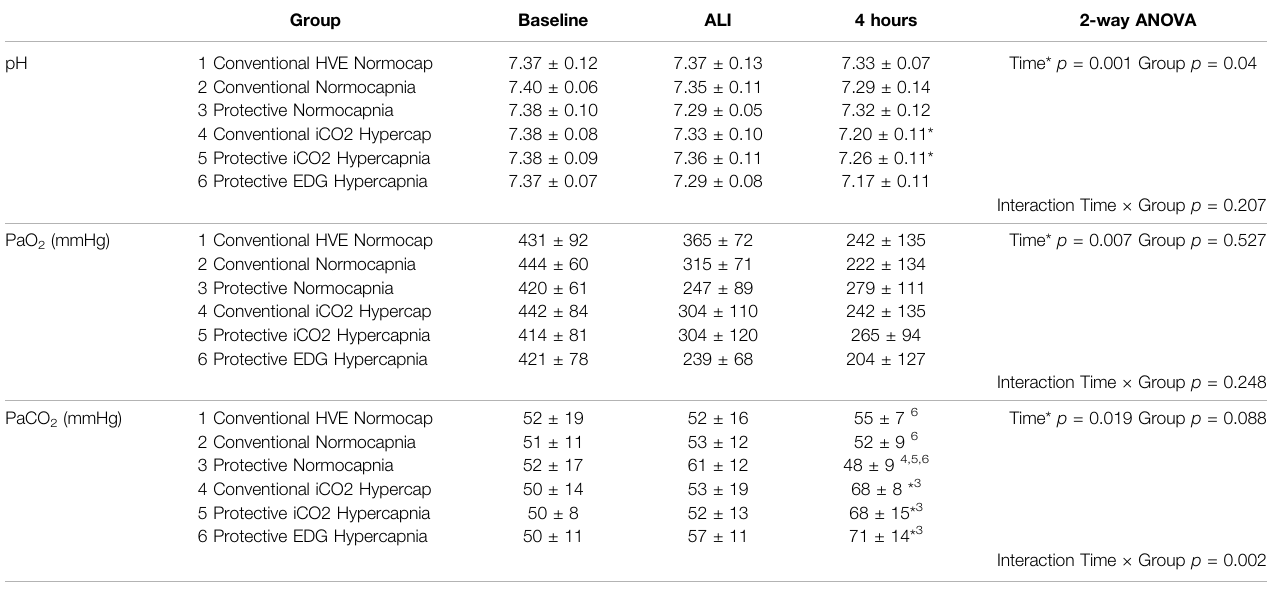
TABLE 4 | Gas exchange measurements at baseline, 1 h and 4 h of ventilation in each group, including pH, partial pressure of O 2 (PaO 2 , mmHg), and partial pressure of carbon dioxide (PaCO 2 , mmHg). Values are expressed as mean ± SD. Baseline data given for reference only, but not included into statistical analysis. * denotes signi fi cant difference vs ALI measurements; numbers denote signi fi cant differences between groups.